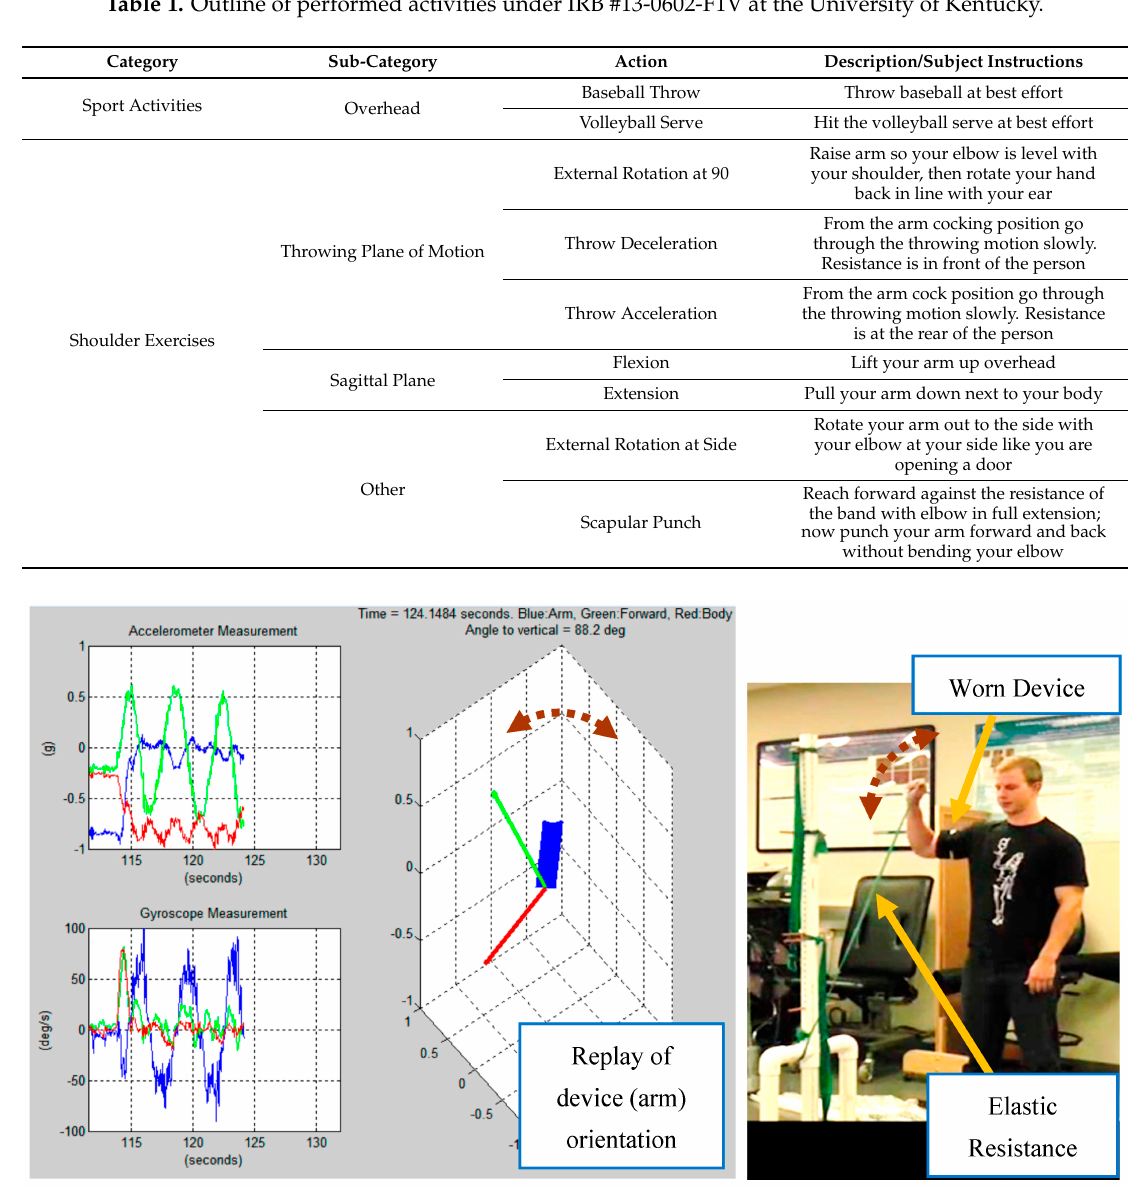
Figure 2. Data collection of an external rotation with arm elevated at 90°, a rehabilitation exercise. Tri-axis accelerometer and rate gyroscope plots are shown along with a playback of the unit’s orientation in space. Blue axis represents the length of the arm, green and red axes represent the remaining two orthogonal axes.